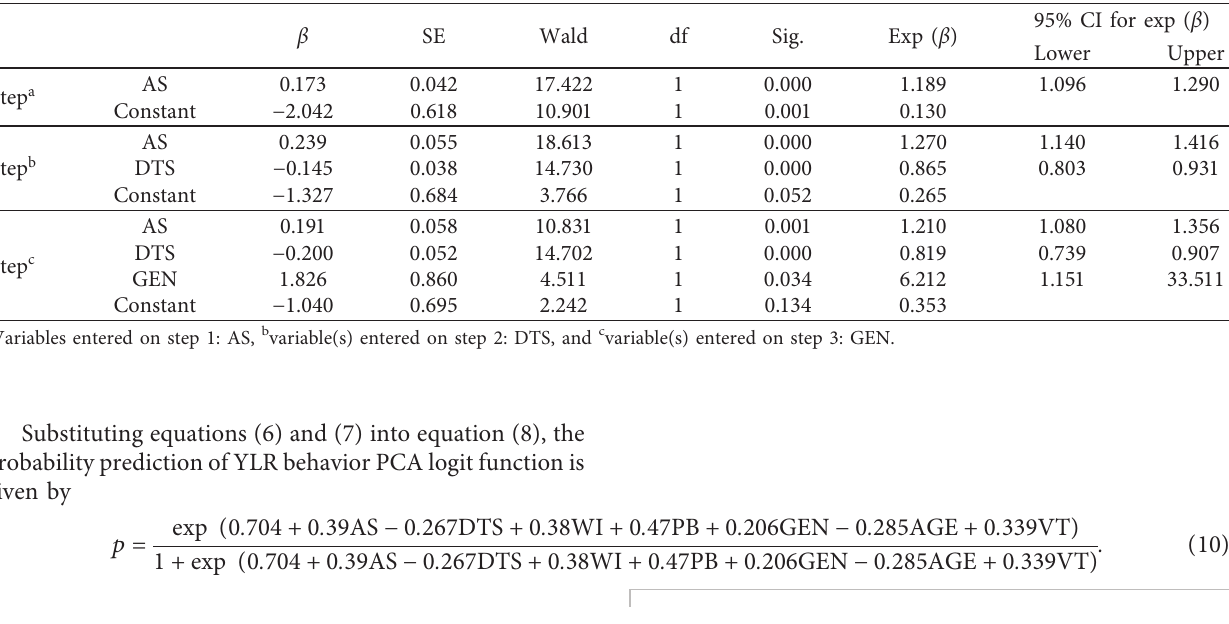
Table 8: Base logistics regression values of the predicting variables.